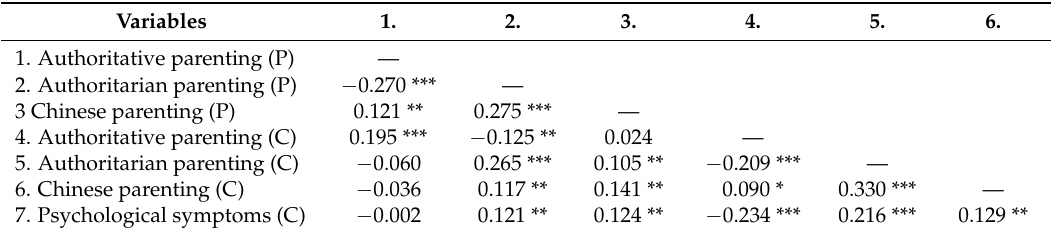
Table 3. Pearson Correlation coefficients among parent-reported parenting, child-perceived parenting, and child psychological